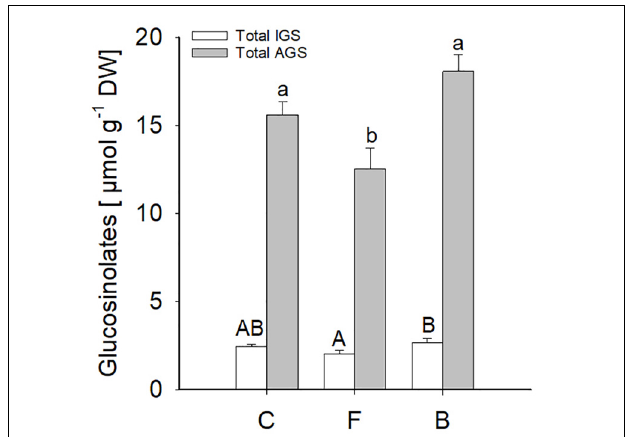
FIGURE 8 | Indole (white bars) and aliphatic (grey bars) glucosinolate levels (means ± SE) measured in B. bassiana colonised (F, FRh2 and B, BG11) and control (C) A. thaliana leaves. Error bars represent the standard error of the mean ( N = 6), bars with different letters differ significantly, ( P < 0.05).